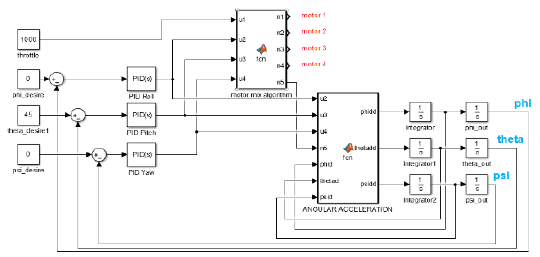
Figure 9. Simulink PID quadcopter system Power consumption